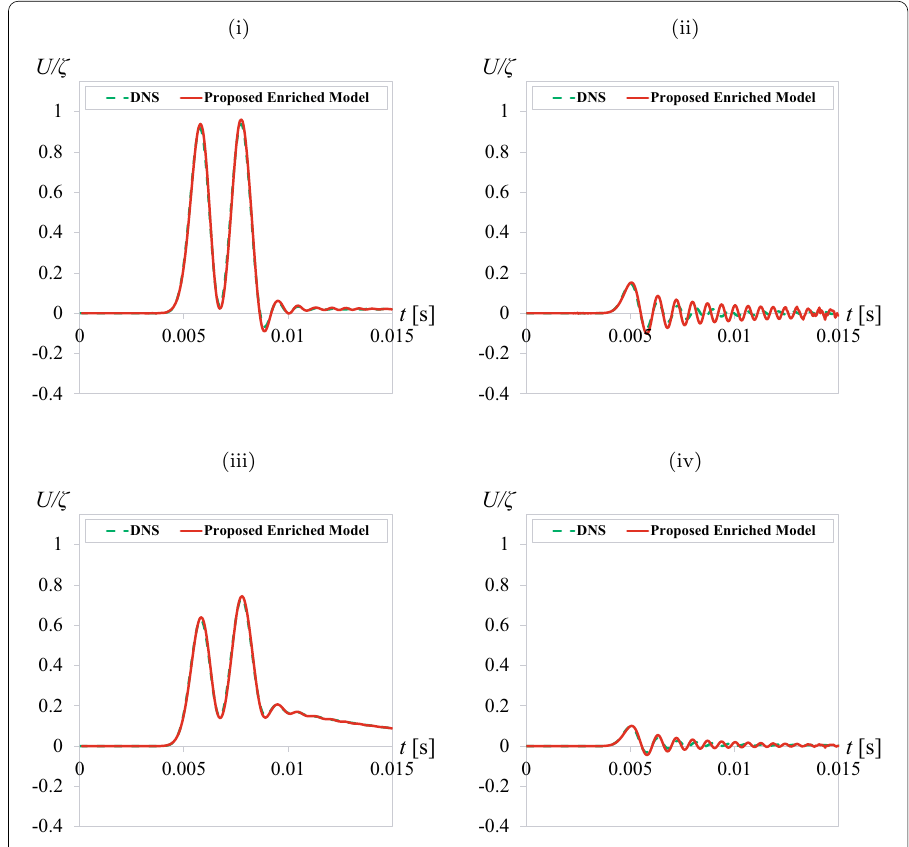
Fig. 10 Metamaterial 2—Homogenized displacement profiles at x = 20 D , with respect to relaxation time [B] ( κ = 0 . 026 s ) for loading frequency F at i 500 Hz, ii 10,000 Hz, and with respect to [C] ( κ = 0 . 0026 s ) for F at iii 500 Hz, iv 10,000